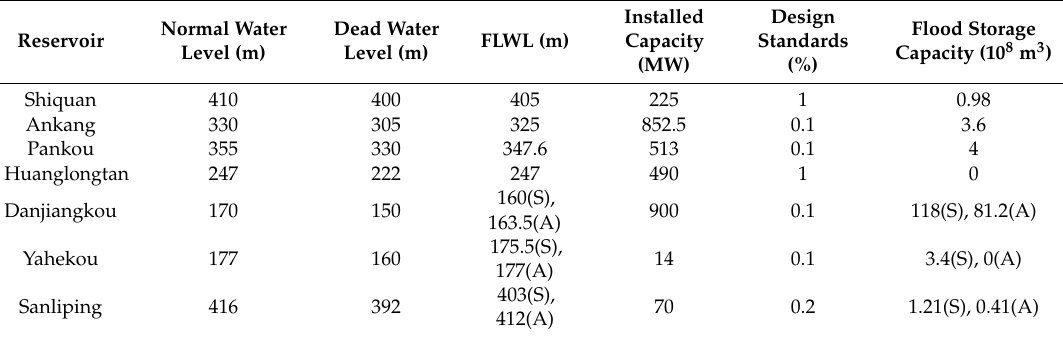
Table 1. Characteristic parameters of the cascade